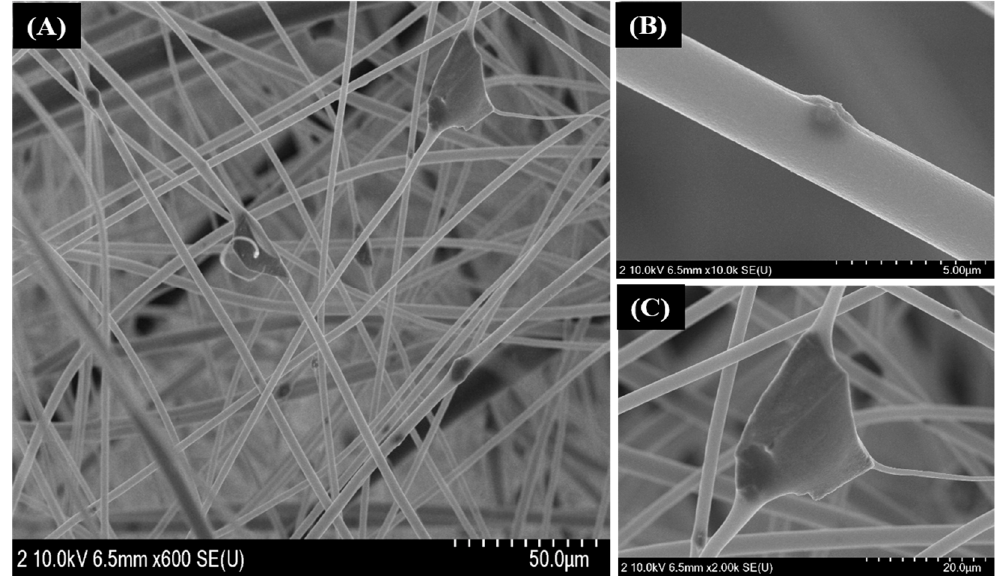
Figure 4. FESEM image of FA/PS NFs membrane ( A ), FA particle embedded inside the PS NFs ( B ), and FA flake-like structure attached to the PS fibers ( C ).